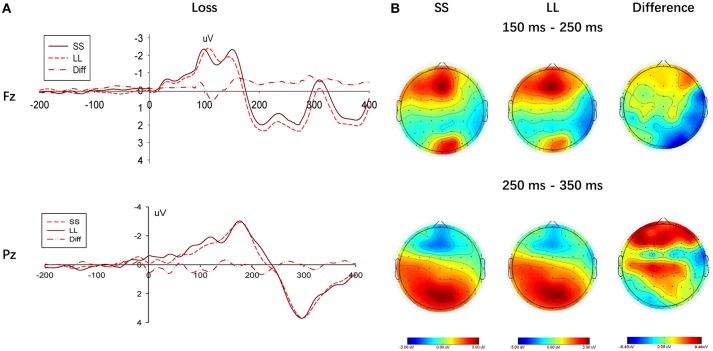
Results of selecting SS option and LL option in the loss condition. (A) Representative example: ERP waveform in Fz and Pz; (B) topographic maps for P200 (150 ms-250 ms), N2 (250 ms-350 ms) and P300 (250 ms-350 ms).